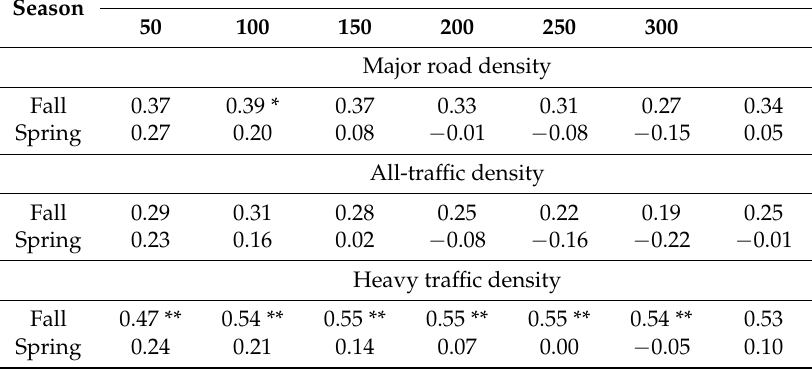
Table 3. Season stratified correlation coefficients of traffic-related metrics with measured black carbon concentrations in two monitoring seasons.